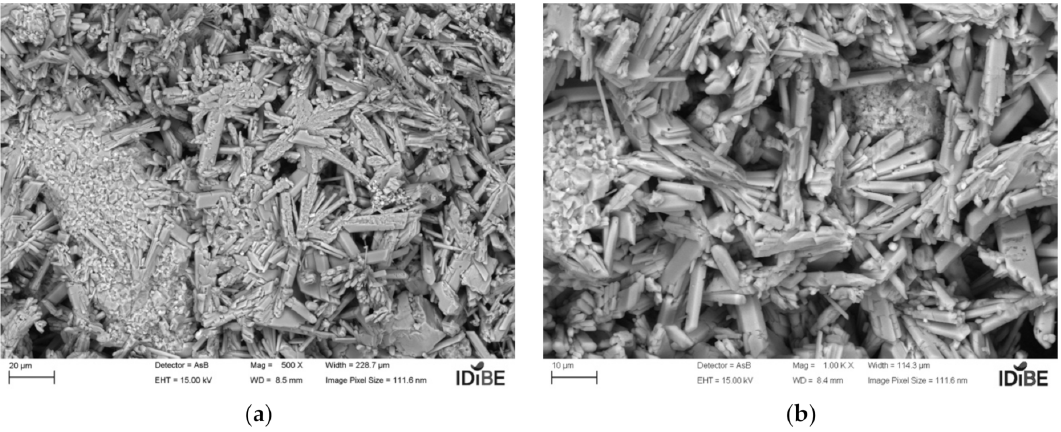
Figure 8. Micrograph of the 1.2% melamine compound (lot C3): ( a ) 20 µ m; ( b ) 10 µ m (source: the author).